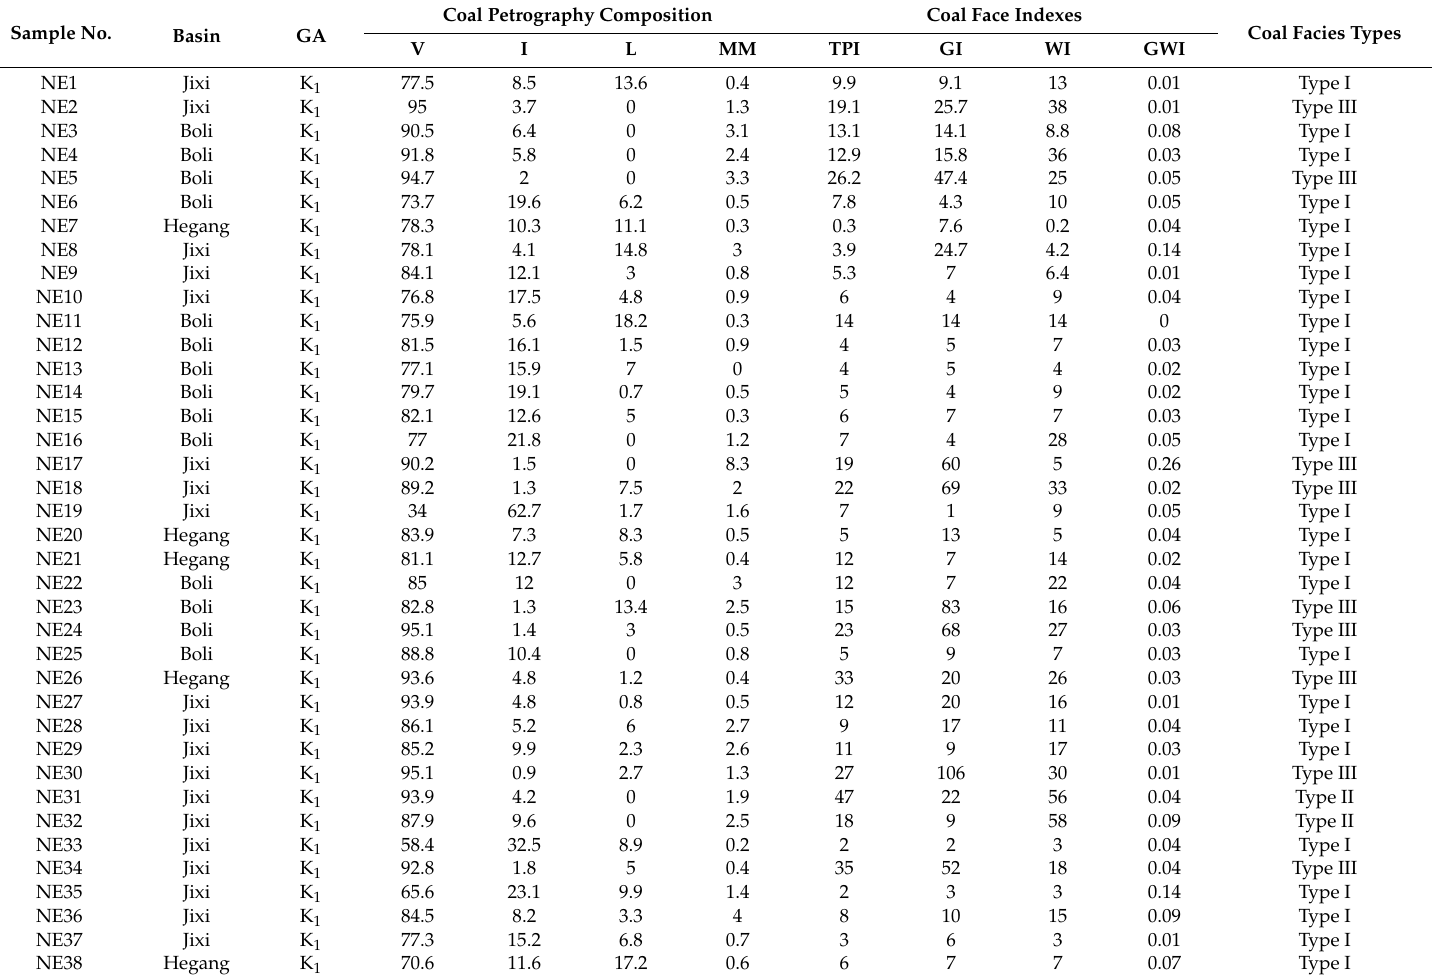
Table 3. Coal facies indexes and coal facies type in Sangjiang-Muling coal-bearing basins. Sample